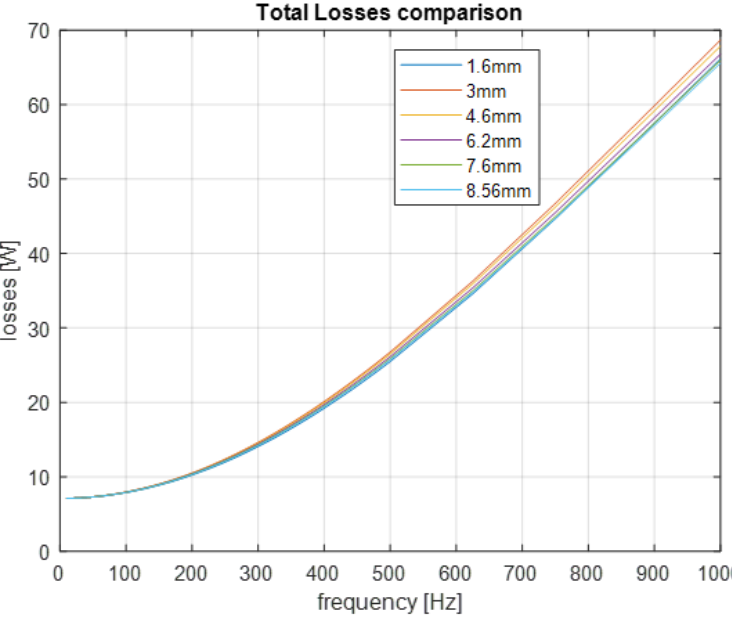
Figure 9. Rectangular slot—Total Losses